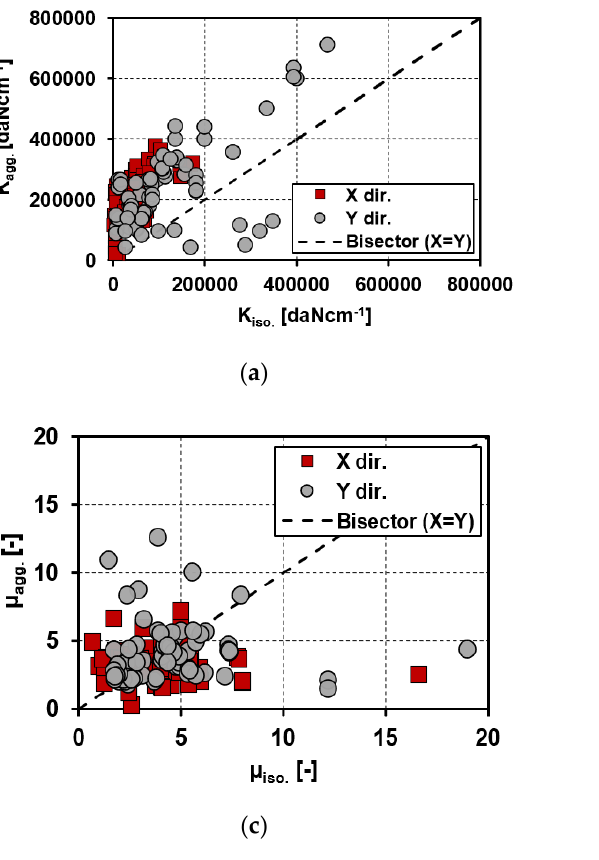
Figure 8. The main EDPs evaluated for aggregate and isolated SUs.